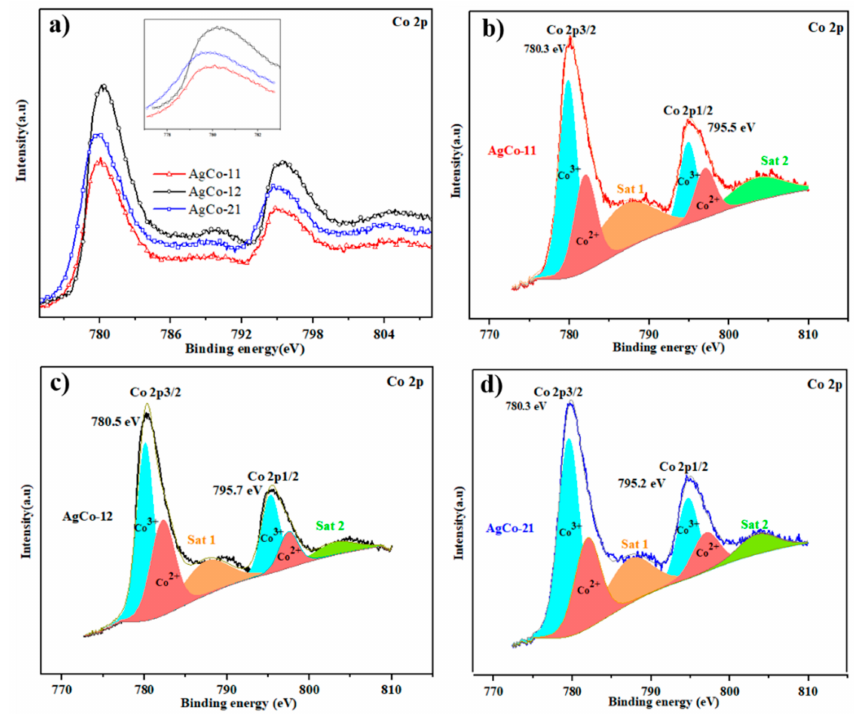
Figure 8. XPS spectrum of Co 2p from bimetallic Ag-Co: ( a ) peak intensity spectrum of Ag 2p and ( b – d ) deconvoluted spectrum of each Ag